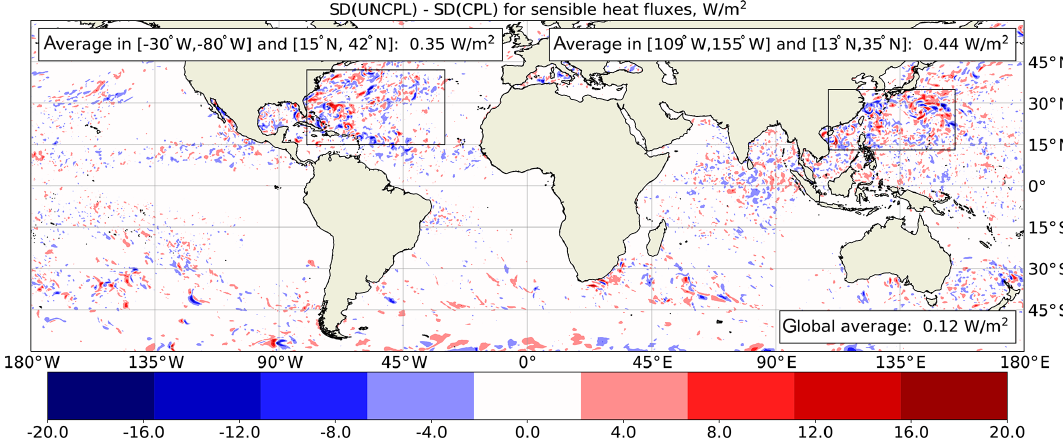
Figure 12. Difference (Wm − 2 ) between the standard deviation of UNCPL and CPL for the turbulent surface sensible heat flux computed using 12h coupled forecasts during September 2017.